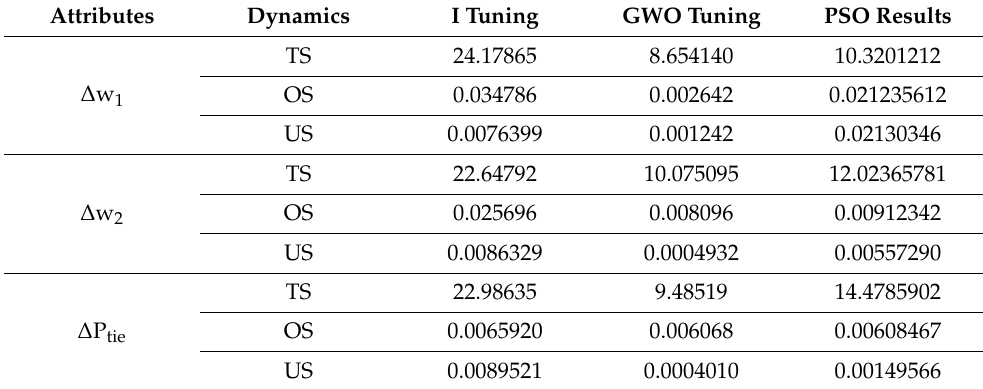
Table 7. Performance of GWO tuning compared with PSO [35] and integral tuning (Undershoot—US, Overshoot—OS, and Time to Settle—TS).